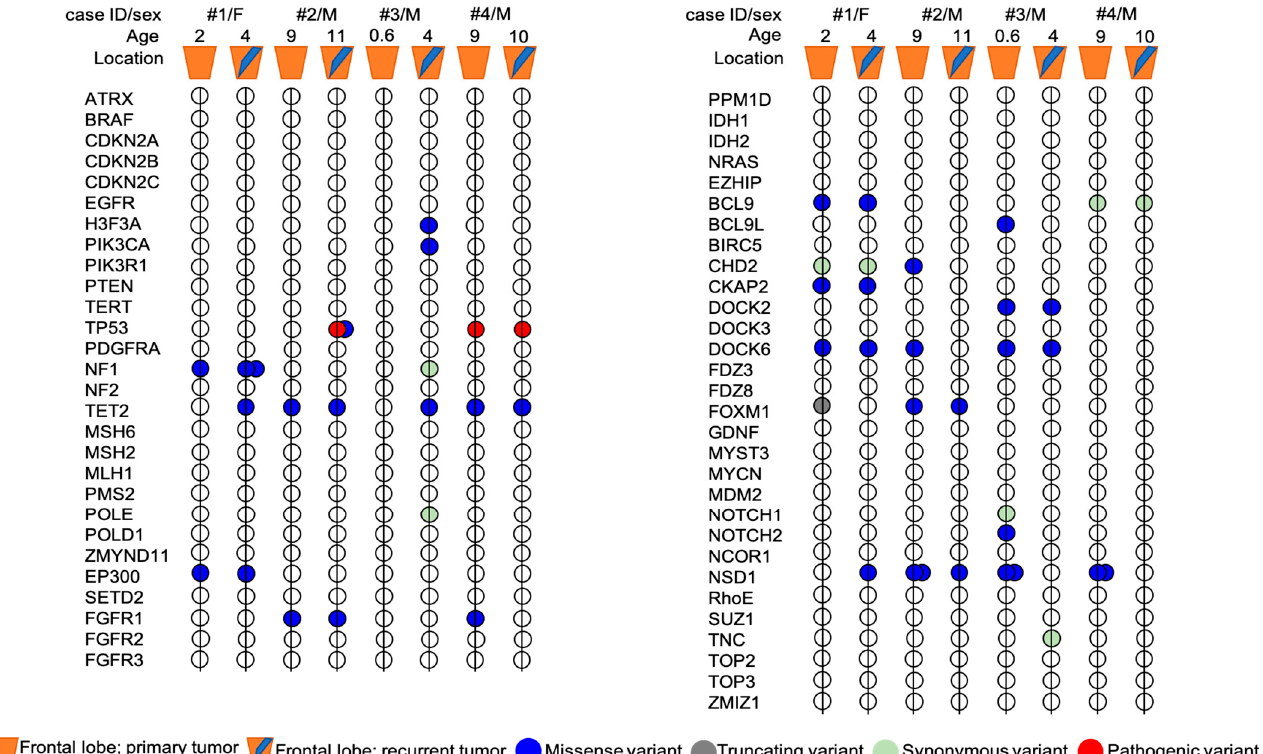
Figure 3. Pie chart representing the frequencies (%) of alterations of the examined genes in this co- hort of pHGGs.